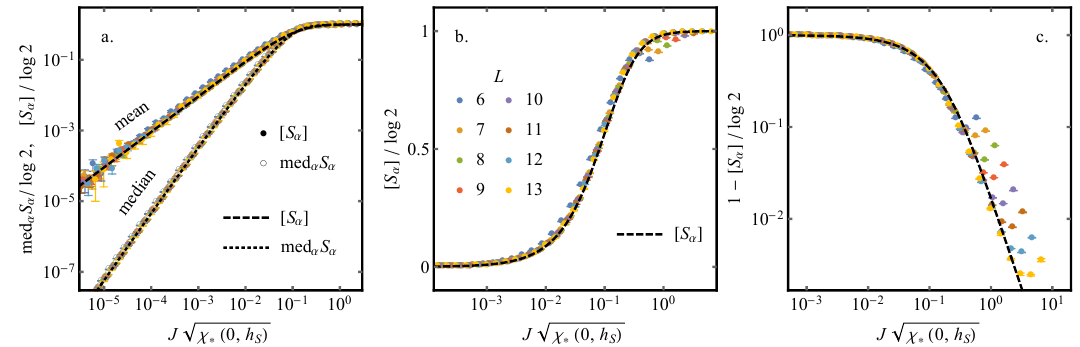
Figure 7: Mean and median eigenstate entanglement entropy of the spin as a function of coupling strength : three panels of the same data which plot the analytic form (81a) (no fit parameters) for the mean entanglement entropy (black dashed) with numeri- cal data (coloured solid points). The panels (a), (b) and (c) are plotted to emphasise the lower tail, crossover region, and upper tail respectively (note the change in y-axis for (c)). As the median is asymptotically separated from the mean in the lower tail we additionally plot this quantity in the left panel. The analytic form for the me- dian (82a) is shown (black dotted) together with numerical data (coloured hollow points). N = 2000 realisations per data point for L ≤ 10, N = 300 for L = 11,12, N = 10 for L =